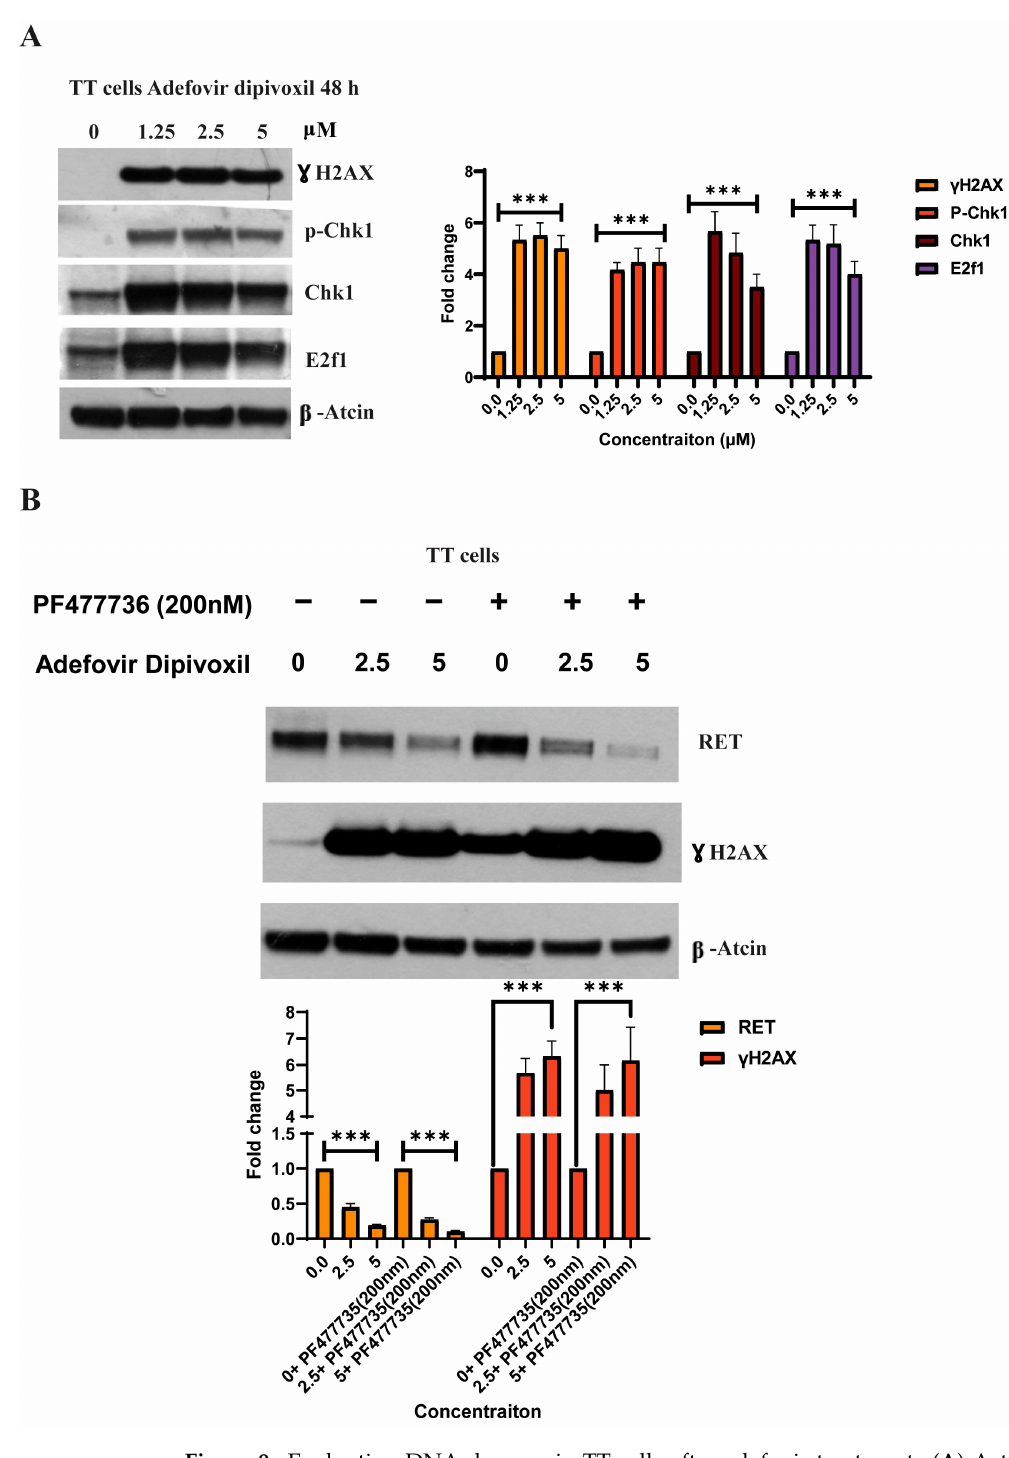
Figure 9. Evaluating DNA damage in TT cells after adefovir treatment. ( A ) Activation of DNA damage checkpoint by adefovir dipivoxil in TT cells. The western blotting results for γ -H2AX, p-Chk1, Chk1, and E2f were quantified by densitometric analysis with normalization to basal expression, and differences among groups were analyzed using one-way ANOVA ( n = 3; *** p ≤ 0.001) ( B ) and effect of Chk1 inhibitor PF-477736 on adefovir dipivoxil-induced RET downregulation in TT cells. The western blotting results for RET and BCL2 were quantified by densitometric analysis with normalization to basal expression, and differences among groups were analyzed using two-way ANOVA with Bonferroni post hoc test ( n = 3, *** p ≤ 0.001). The uncropped blots are shown in Figure S8A and